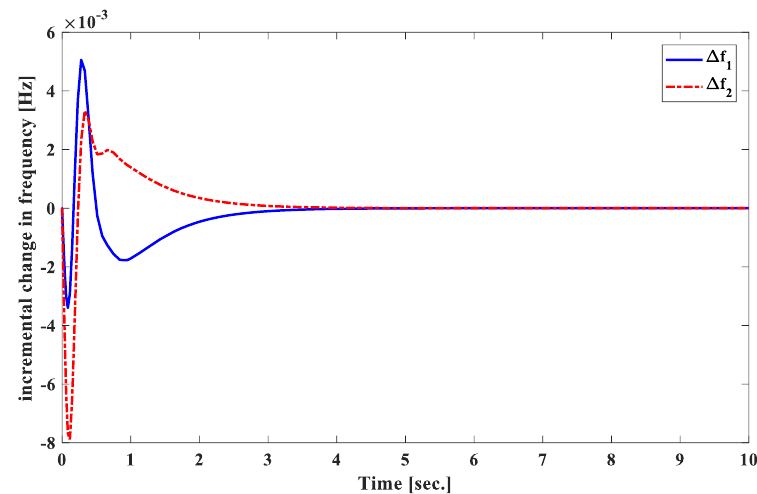
Figure 9. Frequency deviation [Hz] of control areas 1 and 2 with matched disturbances.